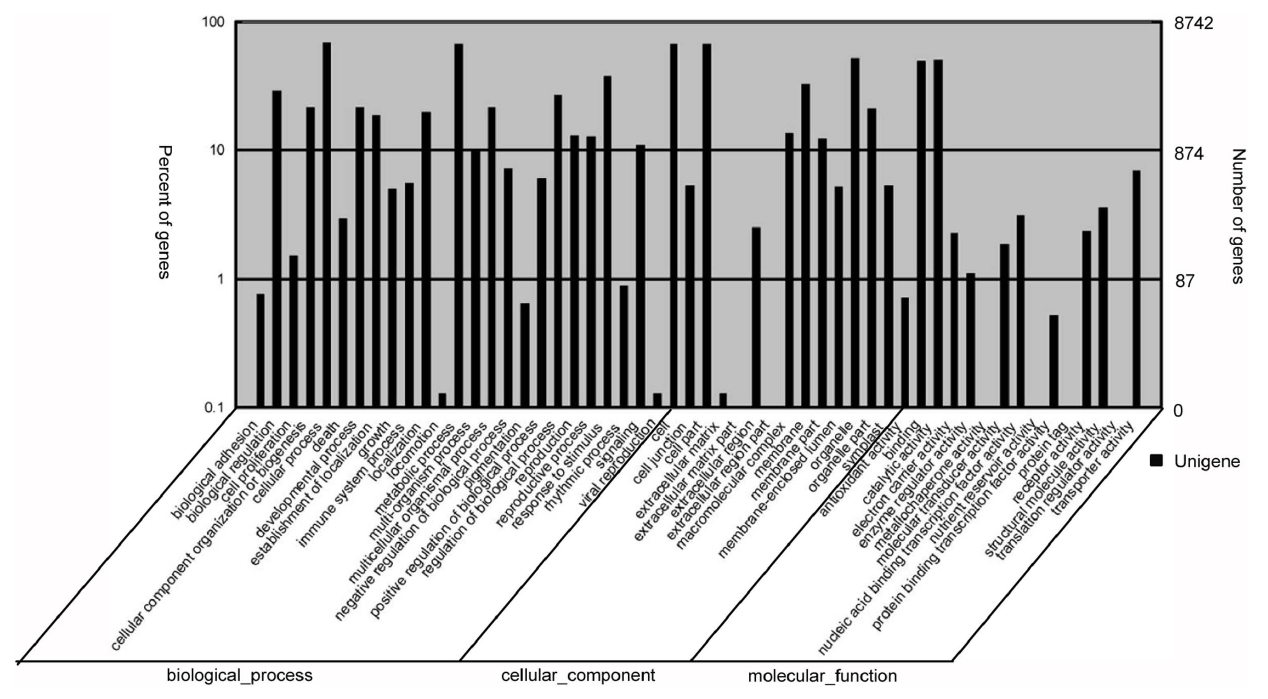
Figure 4. Histogram representation of Gene Ontology classification of DEGs. GO categories, shown in the x-axis, are grouped into three main ontologies: biological process, cellular component and molecular function. The right y-axis indicates the number of genes in each category, while the left y- axis indicates the percentage of total genes in that